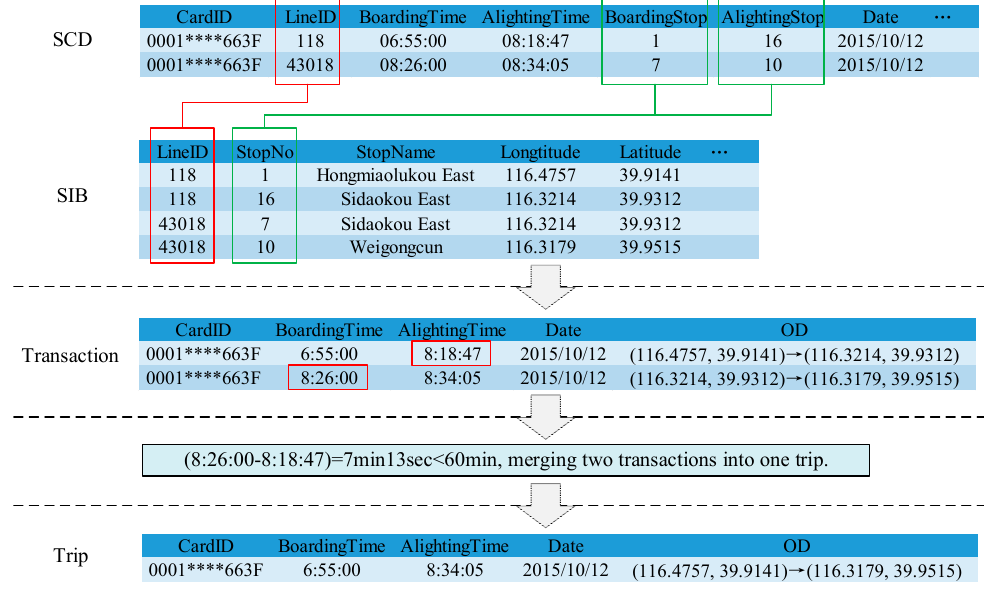
Figure 4. Example of trip reconstruction.